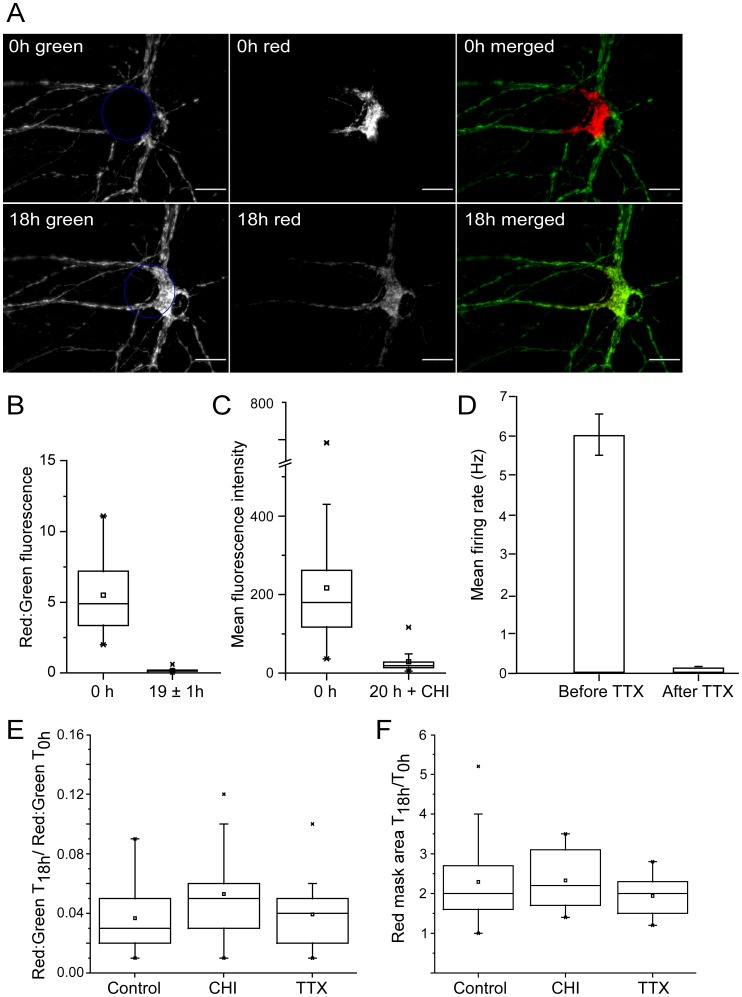
Constitutive redistribution of labeled mitochondria.A) Images of a living motor neuron (24 div) were taken within a minute after photo-converting the mitoKaede protein, and then after 18 hours. Over a period of 18 hours mitochondria from the periphery appeared to extensively fuse with organelles from the cell body. Blue circles in the leftmost panels delineate the area of the neuron that was exposed to blue light. Relative fluorescence intensity levels are directly comparable. Scale bars correspond to 20 microns. B) Quantitation of the redistribution of red and green fluorescent mitoKaede. The mean fluorescence intensity per pixel was calculated for both red and green pixels in masks generated solely based on the distribution of red pixels. For each cell (n = 33), the ratio of red: green mean pixel intensity at time 0 h and after 18 h (19±1 h) is plotted as a box and whisker plot. A decrease in this ratio reflects a dilution of the finite amount of red fluorescent mitoKaede with green fluorescent mitoKaede. The median ratio changed from 4.9 to 0.17. C) The level of expression of a short-lived GFP in motor neurons before and after treatment with CHI was quantified by manually generating masks that encompass the green pixels in the cell soma, and calculating the mean fluorescence intensity (n = 10; p<0.001). D) Patch clamp recordings were performed on infected spinal cord neurons sampled from 4 coverslips (n = 7). Spontaneous spiking activity was recorded over 20 s, and action potentials were blocked in all 7 cases by 1 µM TTX. Data are plotted as mean firing rate of the same cells before and after addition of TTX to the ACSF (p<0.001). E) Pooled data showing no significant effect of cycloheximide (CHI 10 µg per ml, n = 20) or tetrodotoxin (TTX, 1 µM, n = 16) on the redistribution of labeled mitochondria over time compared to untreated motor neurons. For each cell in each treatment group, the ratio of red: green mean pixel intensity after 18 h (19±1 h) is normalized to the starting ratio in the same cell, and plotted as a box and whisker plot. F) Box and whisker plots of the change in the size of masks generated from the distribution of red pixels reflecting the dispersion of red fluorescent mitoKaede over time.